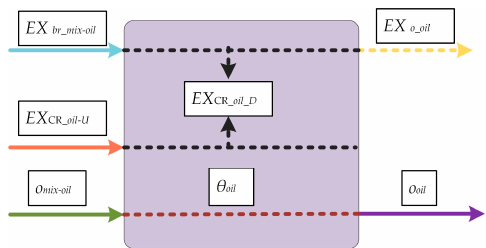
Figure A3. Process flowsheets of CR-oil .